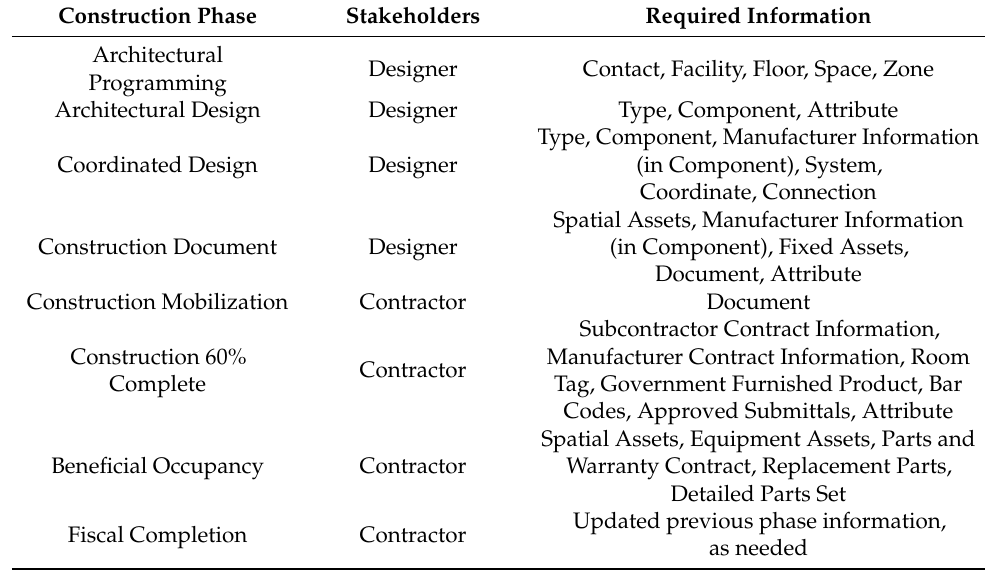
Table 1. Information requested by COBie in each